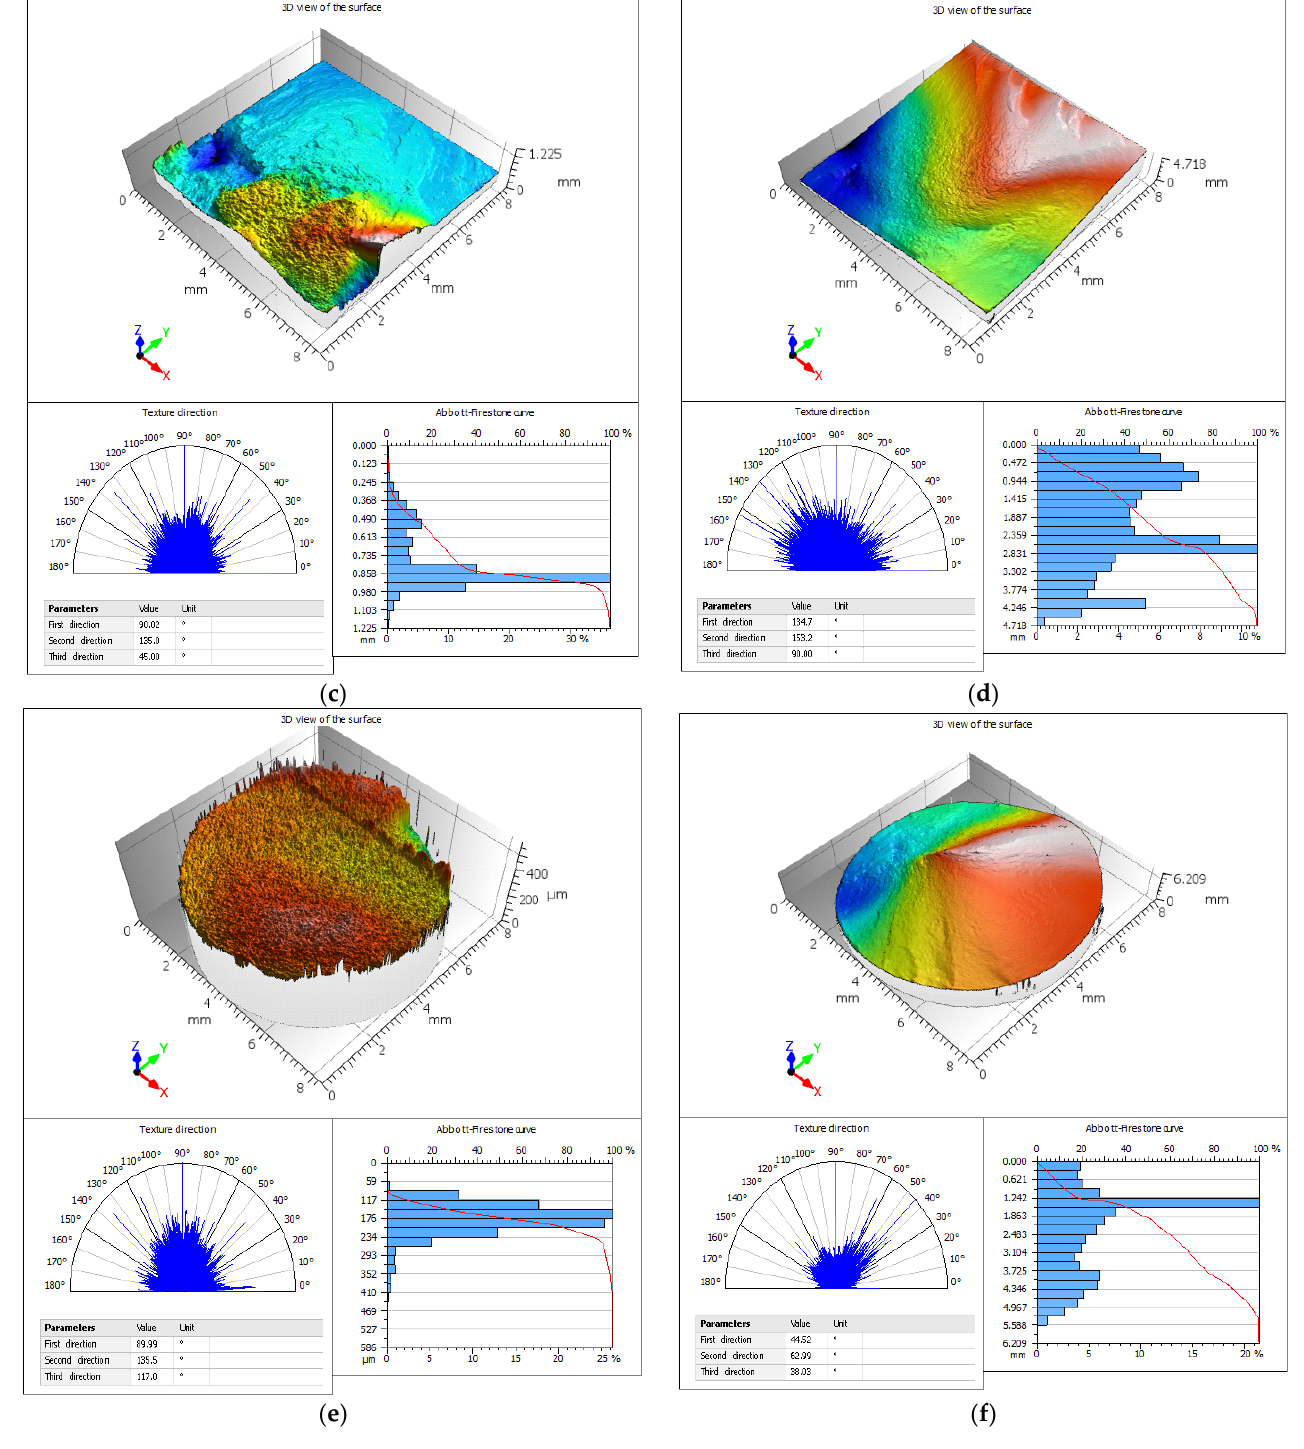
Figure 11. Fractures extremal Df values for: ( a ) max. 10HNAP; ( b ) min. 10HNAP; ( c ) max. 2017-T4; ( d ) min. 2017-T4; ( e ) max. S355J2; ( f ) min. S355J2.